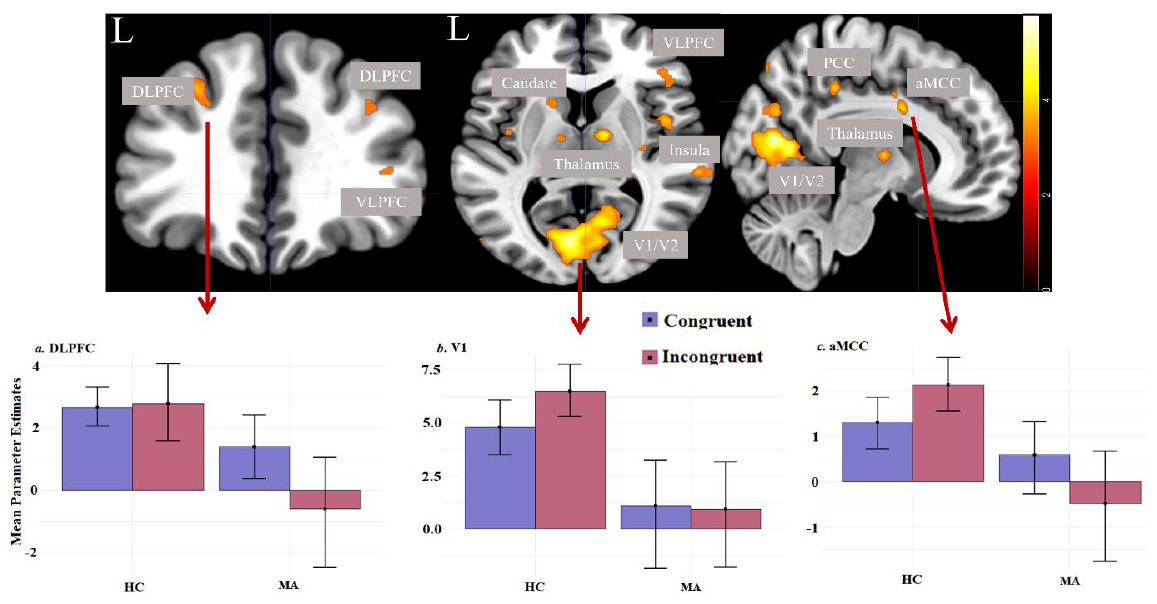
Figure 1. Significant group differences (healthy controls vs. individuals with MA dependence) in brain activation during the incongruent Stroop task condition (voxel-level: p < 0.001 uncorr., cluster- level: corrected according to expected voxels per cluster ≥ 16). The bar graphs depict parameter estimates extracted from the significant cluster in the left DLPFC, aMCC, and V1. ( a ) Averaged parameter estimates, and standard error extracted from the significant cluster in the left DLPFC (local maximum: x = − 37, y = 36, z = 18, cluster size = 65); ( b ) averaged parameter estimates and standard error extracted from the significant cluster in the V1 (local maximum: x = 8, y = − 73, z = 16, cluster size = 3482); ( c ) averaged parameter estimates and the standard error extracted from the significant cluster in the aMCC (local maximum: x = 10, y = 4, z = 32, cluster size = 45). Abbreviations: HC, healthy controls; MA, individuals with methamphetamine dependence; DLPFC, dorsolateral prefrontal cortex; VLPFC, ventrolateral prefrontal cortex; aMCC, anterior midcingulate cortex; V1, primary visual cortex; V2, secondary visual cortex; SMA, supplementary motor Table 2. Maxima of regions showing significantly reduced fMRI signals in individuals with crystal meth dependence, compared to healthy controls in the incongruent Stroop task condition (voxel- level p < 0.001 uncorr., cluster size ≥16, according to the expected voxels per cluster).